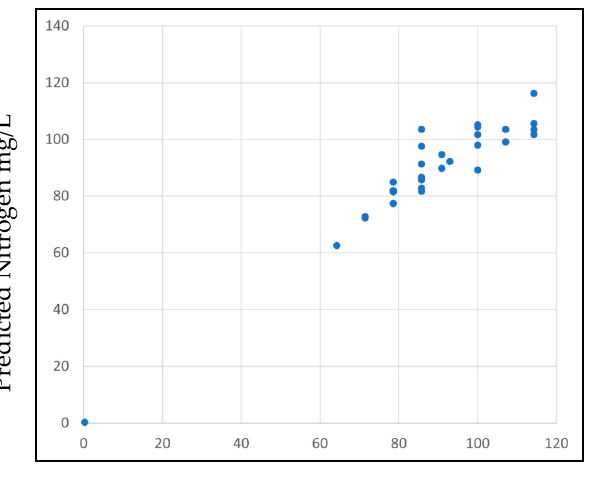
Figure 10. Tank L actual nitrogen plotted against the predicted nitrogen using the MLR model.